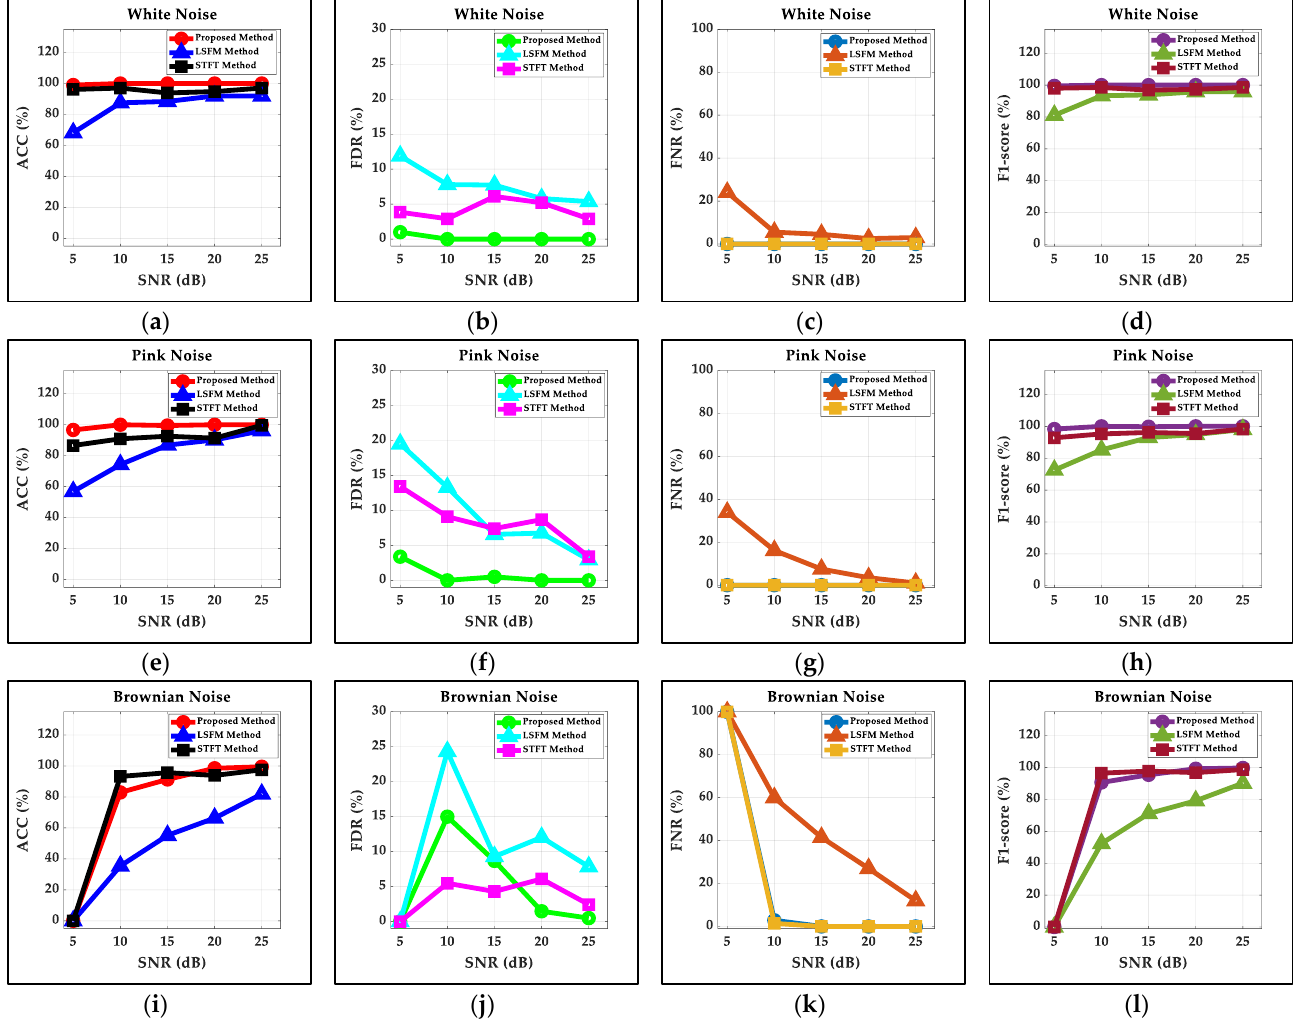
Figure 3. The statistical indicators of the LSFM method, the STFT method and the proposed method for three kinds of additive noise: ( a – d ) the statistical indicators of white noise; ( e – h ) the statistical indicators of pink noise; ( i – l ) the statistical indicators of Brownian noise.